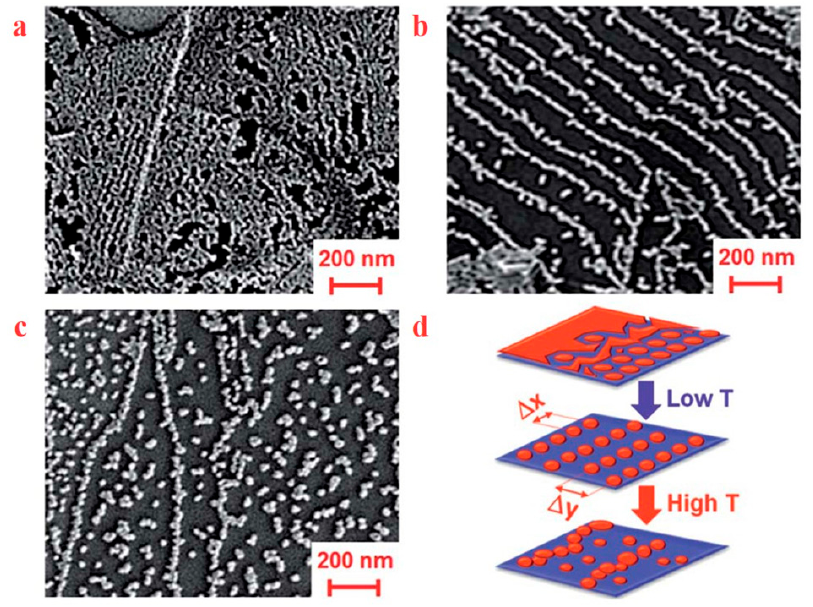
Figure 14. SEM images of copper nanoparticle decorated graphene thin films annealed for 8 hours at ( a ) 200 ◦ C ( b ) 360 ◦ C, ( c ) 440 ◦ C. ( d ) At lower temperatures copper nanoparticles are formed in an uneven layer, which are formed which transitions to assemblies of particles that become spatially separated at the highest temperature. Superlattices formed of lines of nanoparticles are formed at the intermediate temperature of 360 ◦ C. Reproduced with permission from [28], Copyright RSC Advances, 2015.